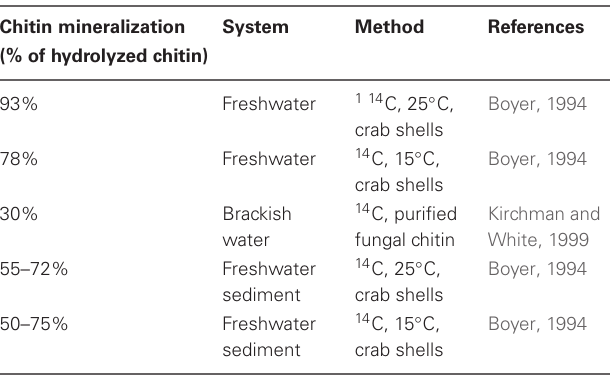
1 14 C: chitin mineralization estimated based on 14 C labeled tracer